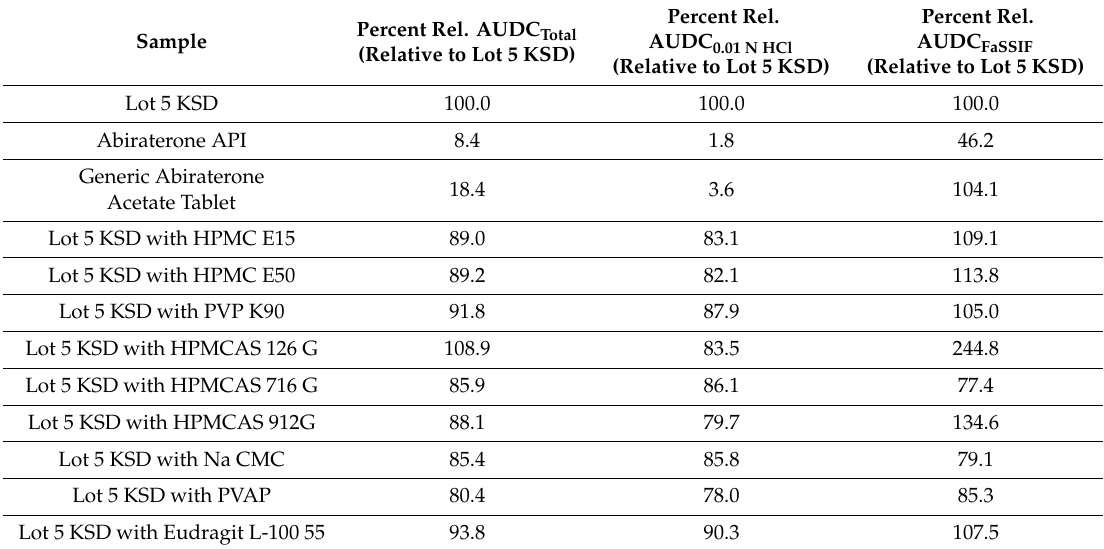
Table 3. Relative area-under-the-drug dissolution curve for the selection of suitable ternary components (i.e., secondary polymers). Sample